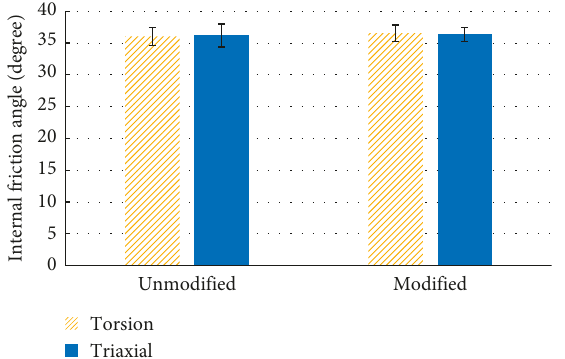
Figure 13: Results of internal friction angle φ of different types of asphalt (60 ° C).